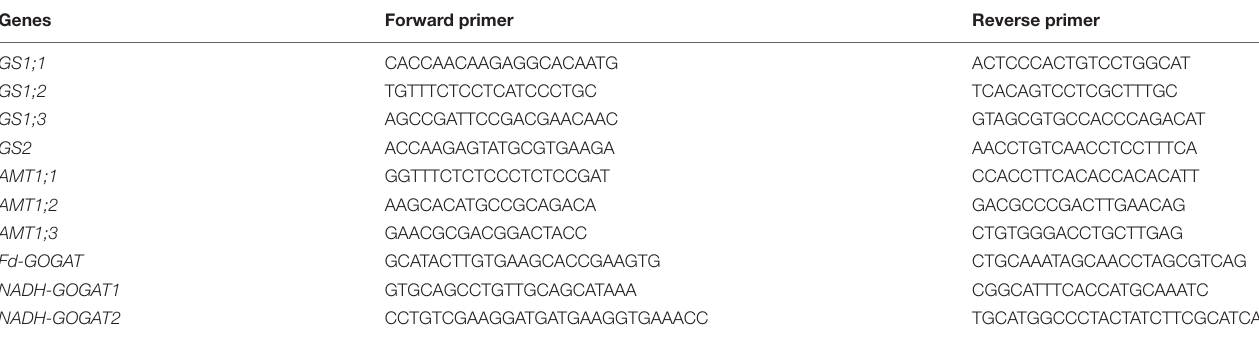
TABLE 3 | Primers used in quantitative